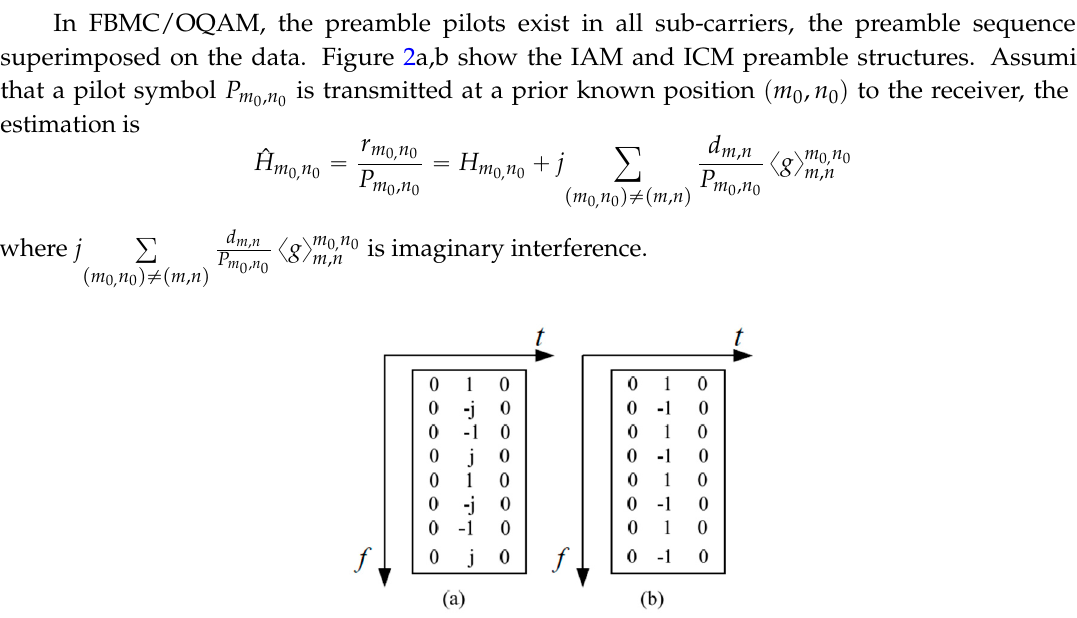
Figure 1. Implementation diagram of the FBMC/OQAM system [35].